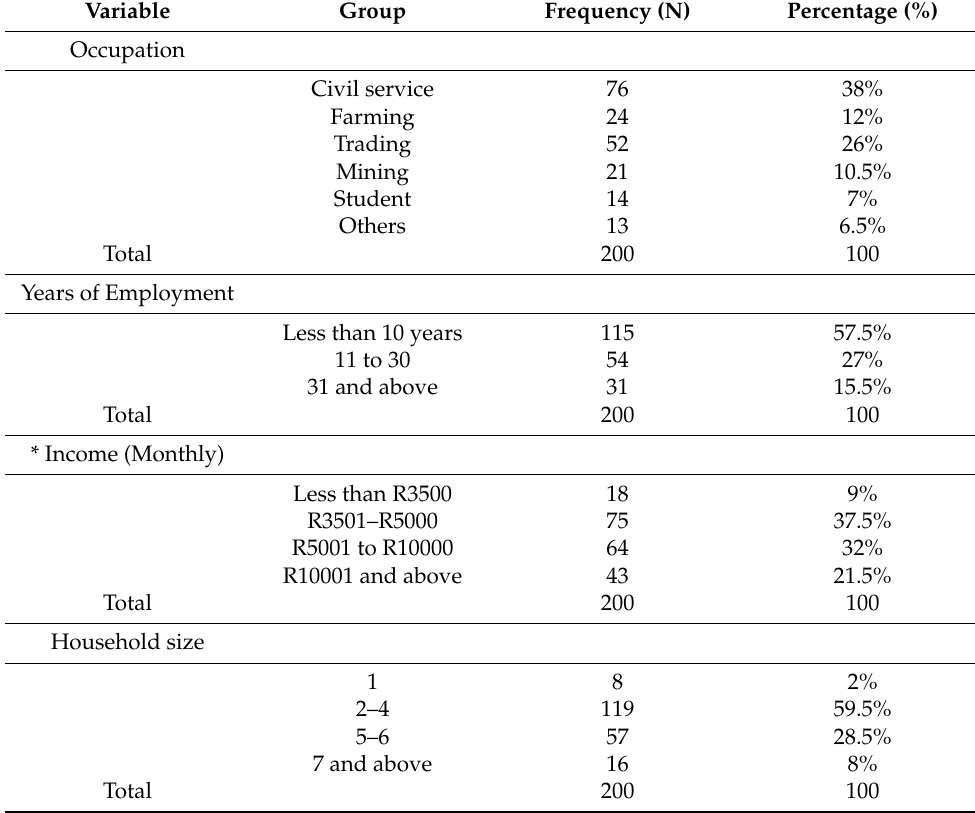
Table 3. Socio-economic characteristics of the